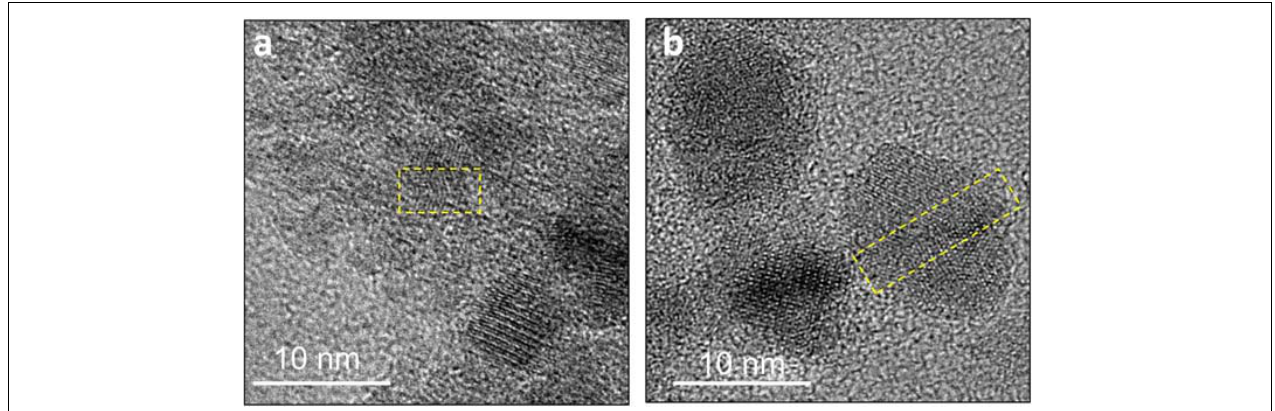
FIGURE 8 | Defects in the crystal structure of Ni-sulfides due to attachment of two or more nanoparticles. (a) A stacking fault in a ∼ 5 nm particle. (b) Twinning in a ∼ 12 nm particle.